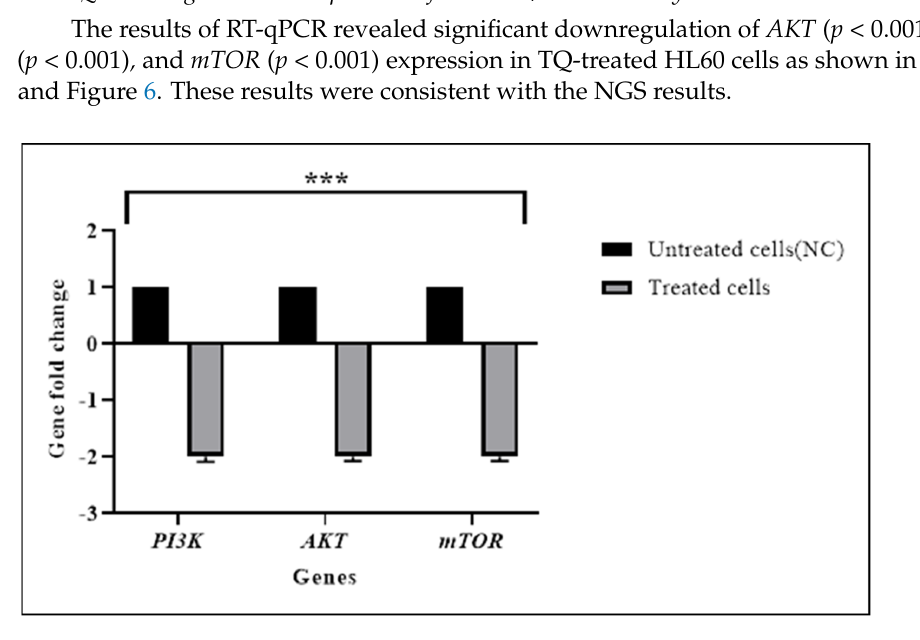
Figure 6. RT − qPCR results of PI3K , AKT , and mTOR expression in HL60 cells. The relative normal- ization of RT − qPCR showed that TQ significantly downregulated the expression of the targeted genes in treated cells. PI3K , AKT, and mTOR were downregulated in treated cells approximately 2-fold lower than in untreated cells. Data are presented as the mean ± SEM (*** p <